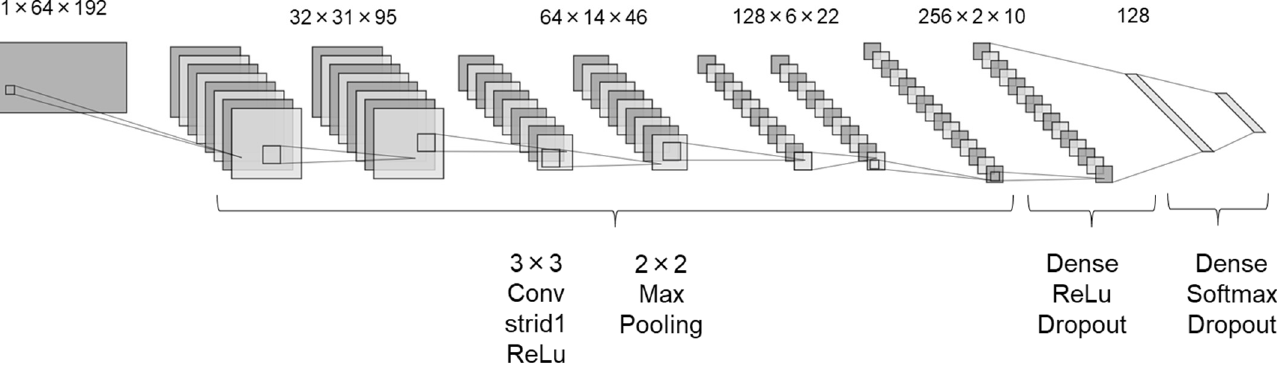
Figure 10. Architecture of the CNN model in use.